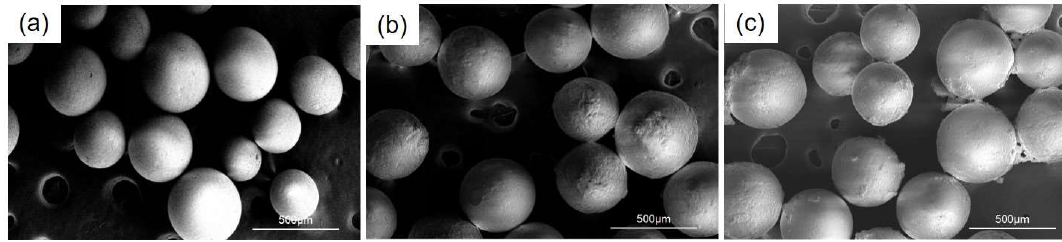
Figure 4. SEM micrographs of ( a ) PLGA microspheres, ( b ) PLGA@PDA microspheres, and ( c ) PLGA@PDA/PEI microspheres.